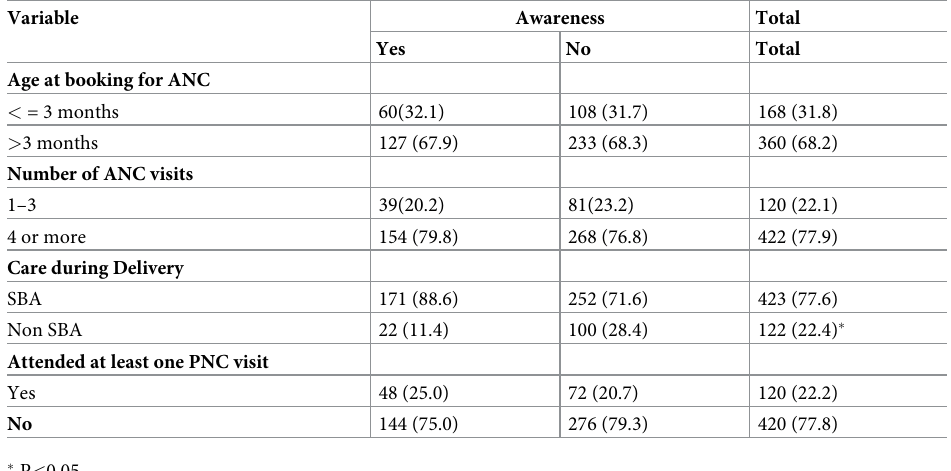
Table 3. Association between rights awareness and utilization of maternal health